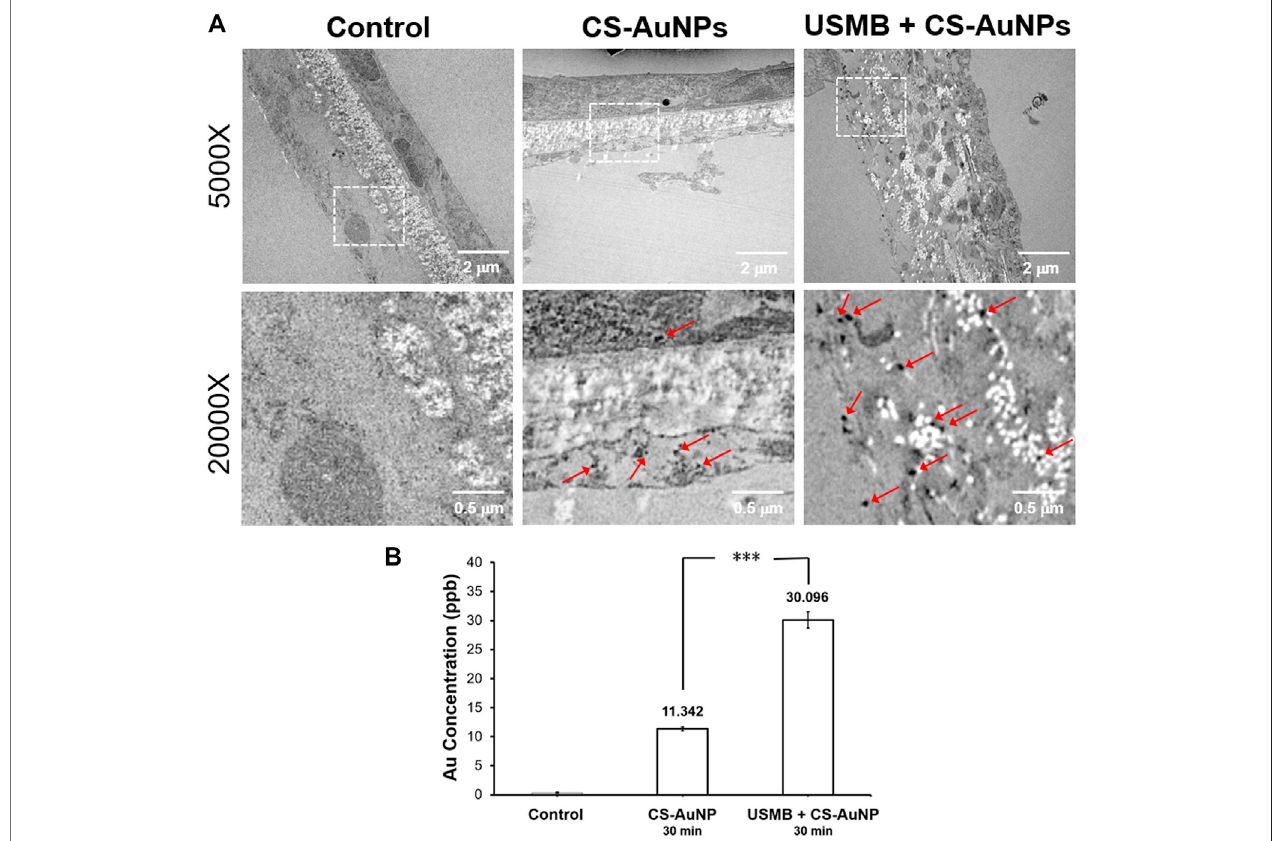
FIGURE 12 | (A) Transmission electron micrographs of a CS-AuNP-treated RWM with or without preceding USMB exposure (upper panels) . The lower panels reveal the magni fi cation of the square region in the upper panels, where multiple AuNPs can be observed (arrows). (B) Comparison of the delivered Au concentration in theinnerearoftheUSMandRWSgroupsbyICP-MSanalysis.Theresultsareexpressedasthemean ± standarderrorofthemean,with n (cid:2) 4foreachbar.*** p < 0.001; CS-AuNP, chitosan-coated gold nanoparticles; USMB, ultrasound